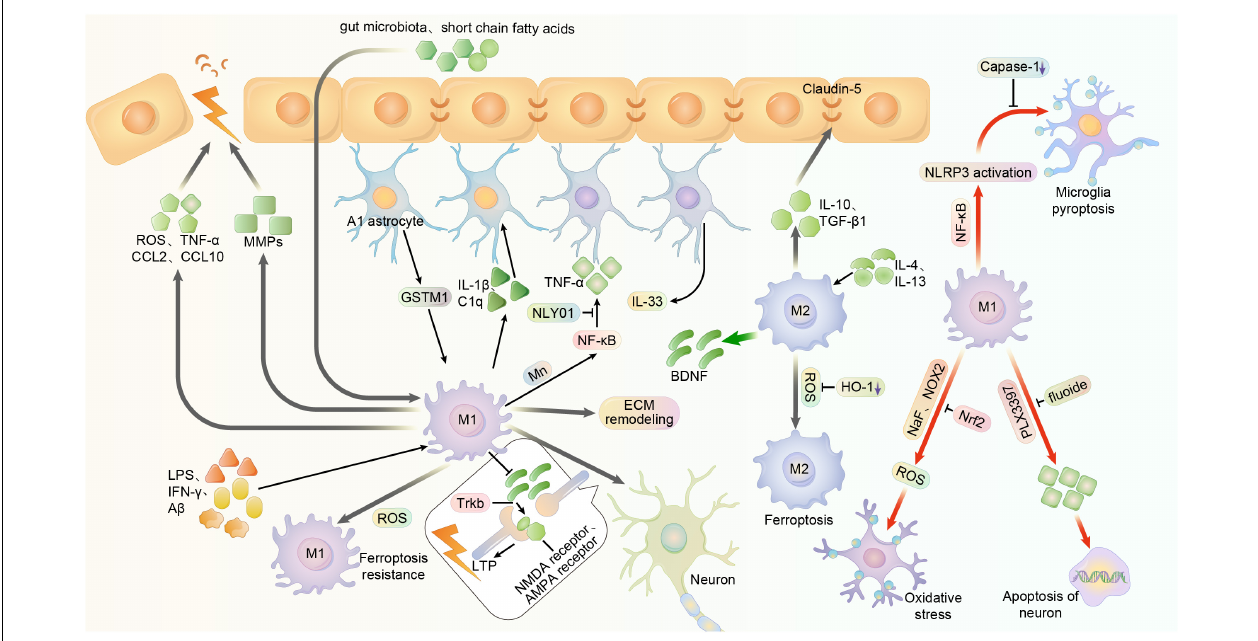
FIGURE 3 | Multiple function of microglia polarization in the central nervous system. Usually, microglia can be activated to M1 phenotype in central system by LPS, IFN- γ , and A β , exerting pro-inflammatory effects. And it can be stimulated to M2 phenotype by IL-4 and IL-13, exerting anti-inflammatory effects. NaF and NOX2 may promote the oxidative stress of microglia and its subsequent impact, while it can reversed by enhanced Nrf2. Meanwhile, the substances like Short-chain fatty acids and gut microbiota that are outside the BBB can also activate microglia by crossing the BBB. However, activated M1 microglia can damage the blood-brain barrier by secreting ROS, TNF- α , chemotactic proteins CCL2 and CXCL10. And in some cases, the over-activated microglia may produce cytokines and MMPs that further impair blood-brain barrier function. The integrity of BBB is related to the cellular junctions, in which the claudin-5 is an important factor. And the M2 phenotype of microglia can produce IL-10 and TGF- β 1 to stabilize the BBB. Astrocyte-specific GSTM1 may enhance inflammatory responses of activated microglia. And microglia can release inflammatory mediators such as Il-1 α , TNF and C1q to convert astrocytes to the neurotoxic A1 phenotype, enhancing the inflammation. Mn toxicity-induced activation of NF- κ B signaling in microglia, which can also regulate cytokines and chemokines, promotes the A1 phenotype of astrocytes. NLY01 can prevent the microglia from releasing these mediators and cytokines, thus inhibiting the conversion of astrocyte. Astrocyte can also produce IL-33, which might activate microglia to remodel the extracellular matrix, showing a capability to restrain the synaptic plasticity. M1 microglia can prevent the BDNF from releasing, thus reducing activation and phosphorylation of synaptic TrkB receptors and inhibiting the expression of glutamate transporters and NMDA receptors, ultimately impairs LTP. But in other cases, M2 microglia might produce BDNF to improve it. The fluoxetine can induce apoptosis of activated microglia, while depletion of such activated microglia with PLX3397 reduces neuronal apoptosis. NF- κ B is able to promote the activation of microglia and the expression of NLRP3, thus initiating pyroptosis of microglia. But the inhibition of caspase-1 reduces microglia pyroptosis. M1-polarized microglia exhibit higher resistance, whereas M2-polarized microglia exhibit higher sensitivity. But the inhibition of HO-1 may reduce the risk of